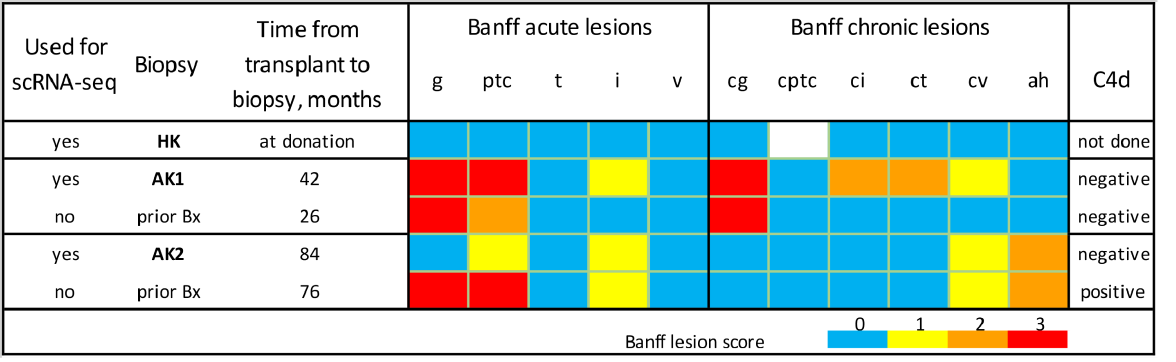
Fig 1. Histopathological characteristics of kidney biopsies. Figure depicts the histopathological characteristics of the kidney biopsies used for scRNA-seq, HK, AK1 and AK2. Allograft biopsies, AK1 and AK2, were evaluated by light, immunofluorescence, and electron microscopy. Colors represent semi-quantitative Banff lesion scores from 0 to 3. Banff acute lesions include glomerular inflammation (g), peritubular capillary inflammation (ptc), tubular inflammation (t), interstitial inflammation (i), and vascular inflammation (v). Banff chronic lesions include chronic glomerulopathy (cg), peritubular capillary basement membrane multilayering (cptc), interstitial fibrosis (ci), tubular atrophy (ct), chronic vascular lesions (cv), and arteriolar hyaline thickening (ah). Peritubular capillary staining for complement split product 4d (C4d) by immunofluorescence was